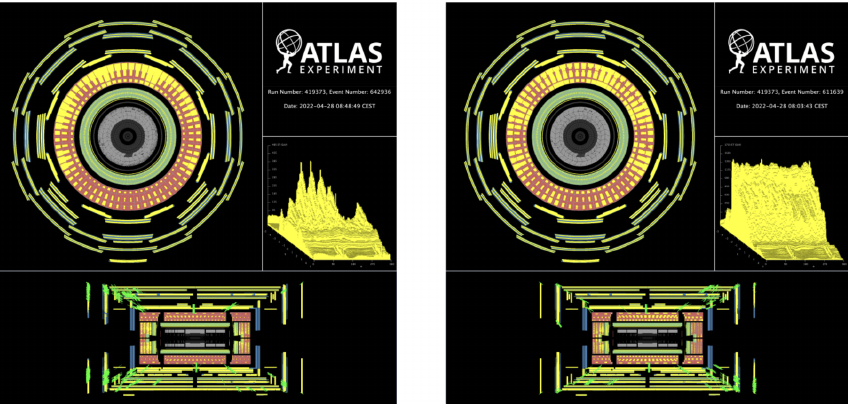
Figure 11. Illustrations of data events recorded by the ATLAS detector from the LHC Run 3 beam splashes tests in April 2022. In the event shown on the left, the spray of particles enters ATLAS from the right hand side of the picture (the A-Side of the detector) travelling to the left (the C-Side), while in the event shown on the right the particle enter ATLAS from the lefthand side of the picture (the C-Side of the detector) and travel to the right (the A-Side). In both images, the yellow boxes show energy deposits in all layers of the ATLAS detector. From the centre moving outwards, the image shows particle interactions in the inner tracking detectors, in the electromagnetic and hadronic calorimeters, and in the muon